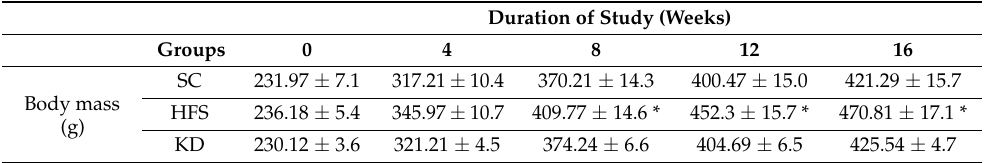
Table 3. Body weight of SC-, HFS-, and KD-fed rats at the beginning of the study (week 0) and after 4, 8, 12, and 16 weeks of dietary